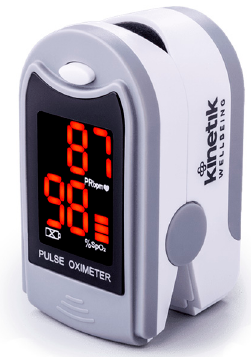
Figure 13. An example of a pulse oximeter from Kinetik wellbeing; https://www.kinetikwellbeing.com/ (accessed on 19 August 2022).